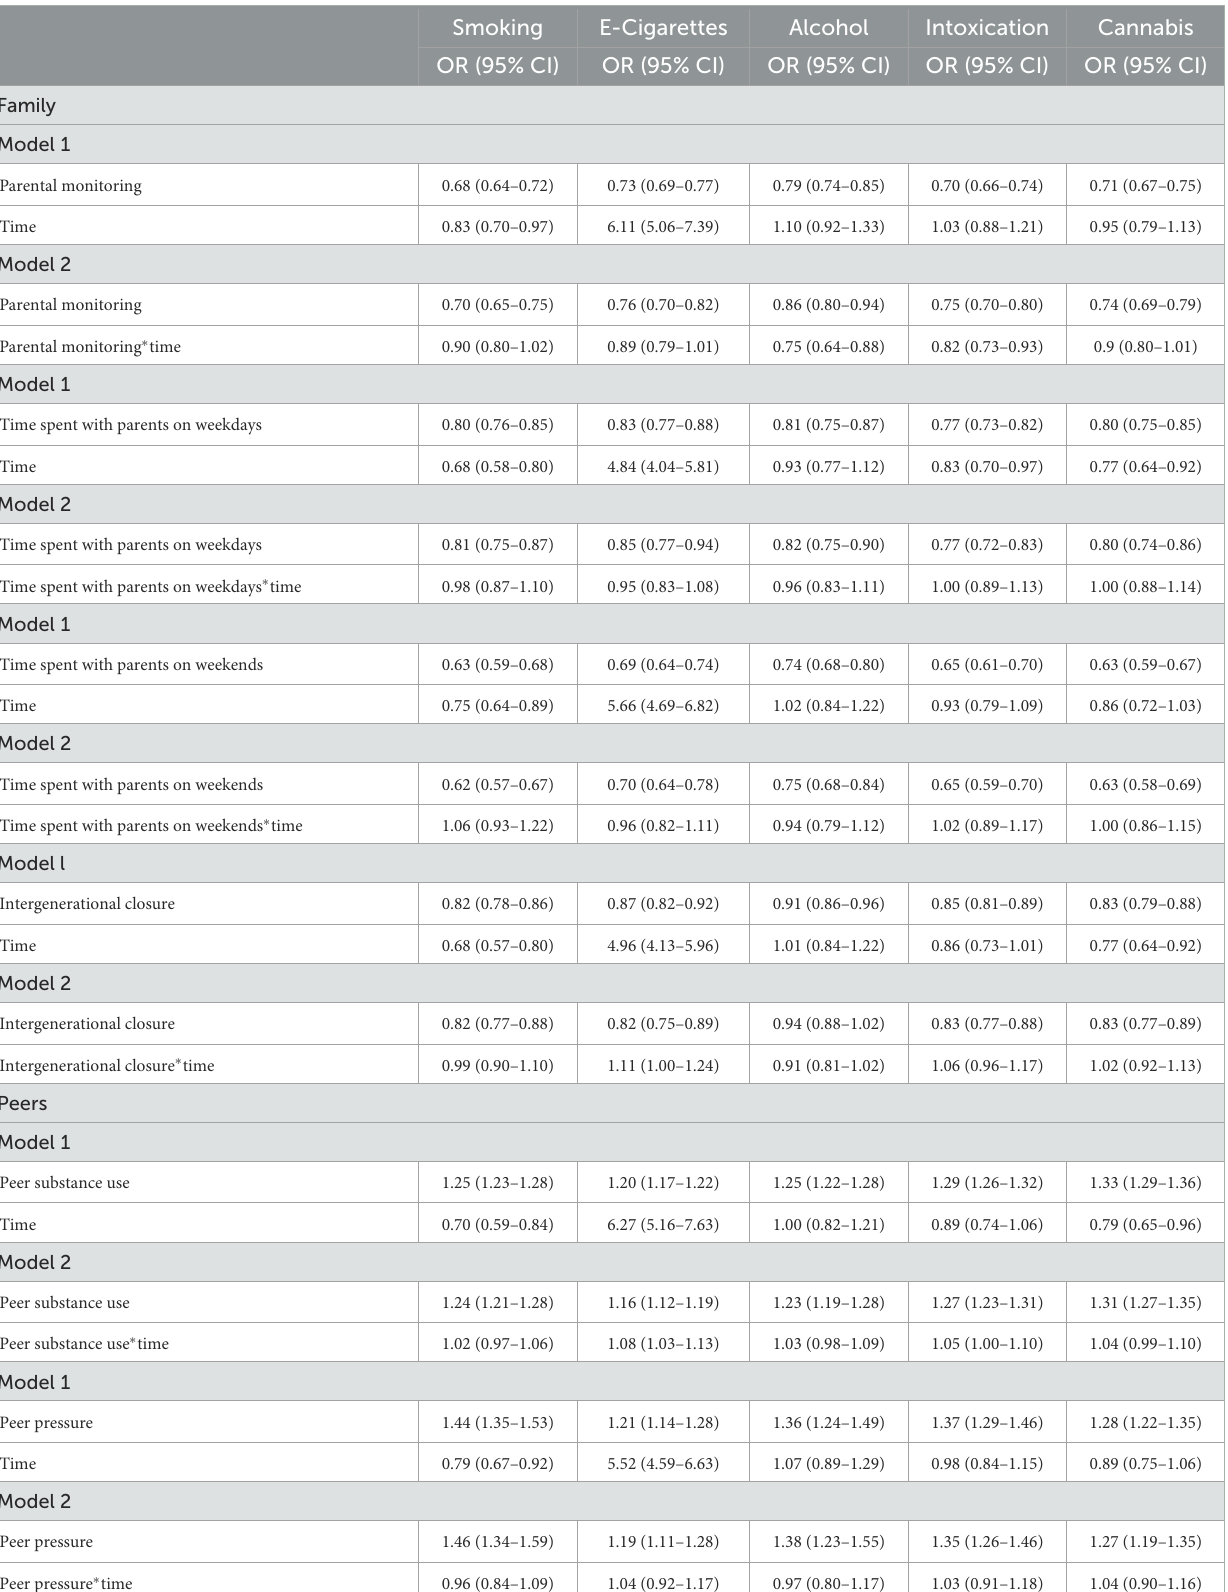
TABLE 3 Exponentiated logistic regression results and accompanying 95% confidence intervals of IPM risk and protective factors and lifetime substance